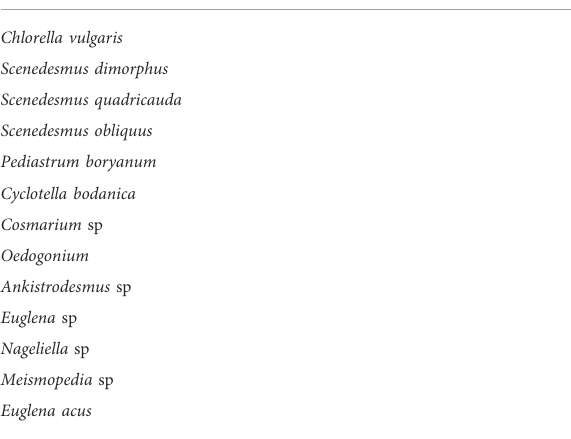
TABLE 2 Microalgal diversity during the experimental study. Microalgal